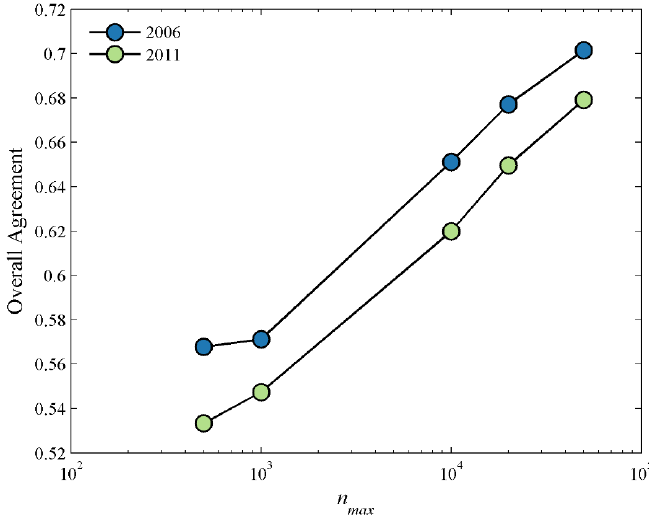
Figure 6. Overall agreement between NLCD and AASG2 as a function of n max .